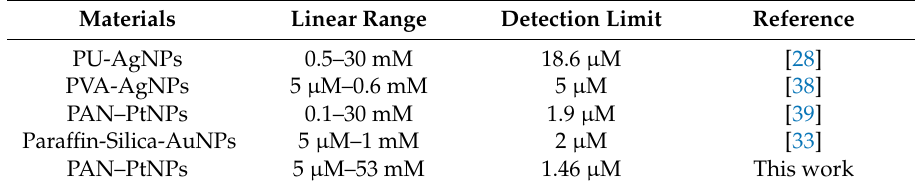
Table 1. Comparison of the performance of the present work with other electrochemical H 2 O 2 sensors.